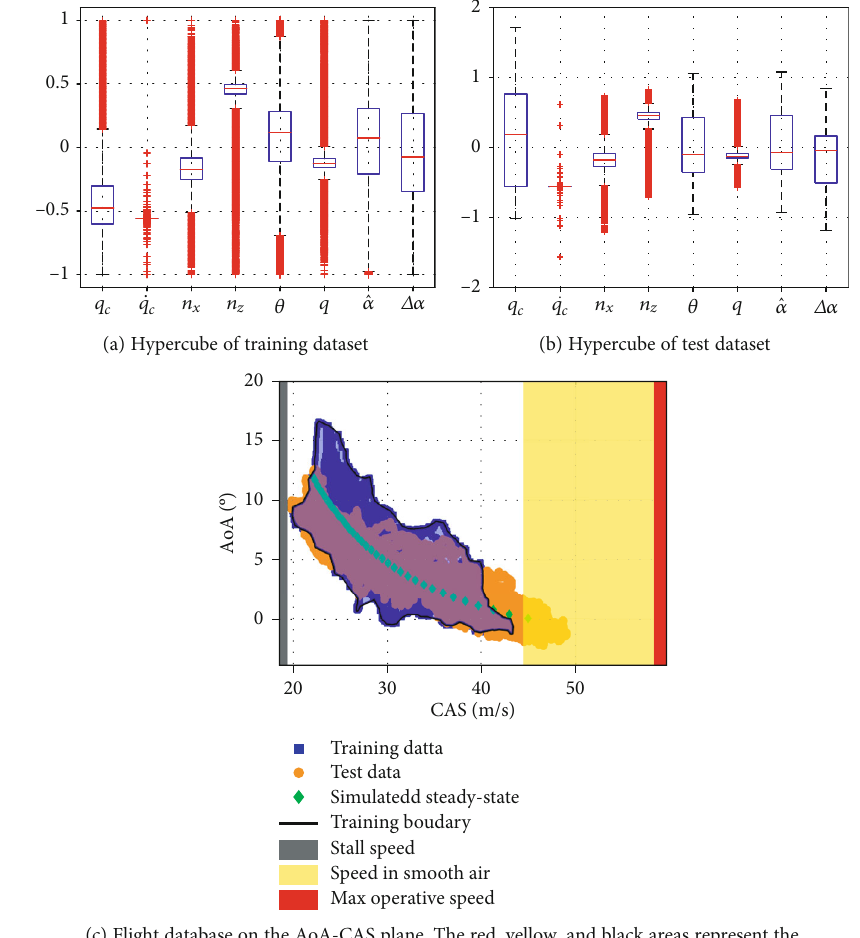
Figure 3: Comparison between training and test